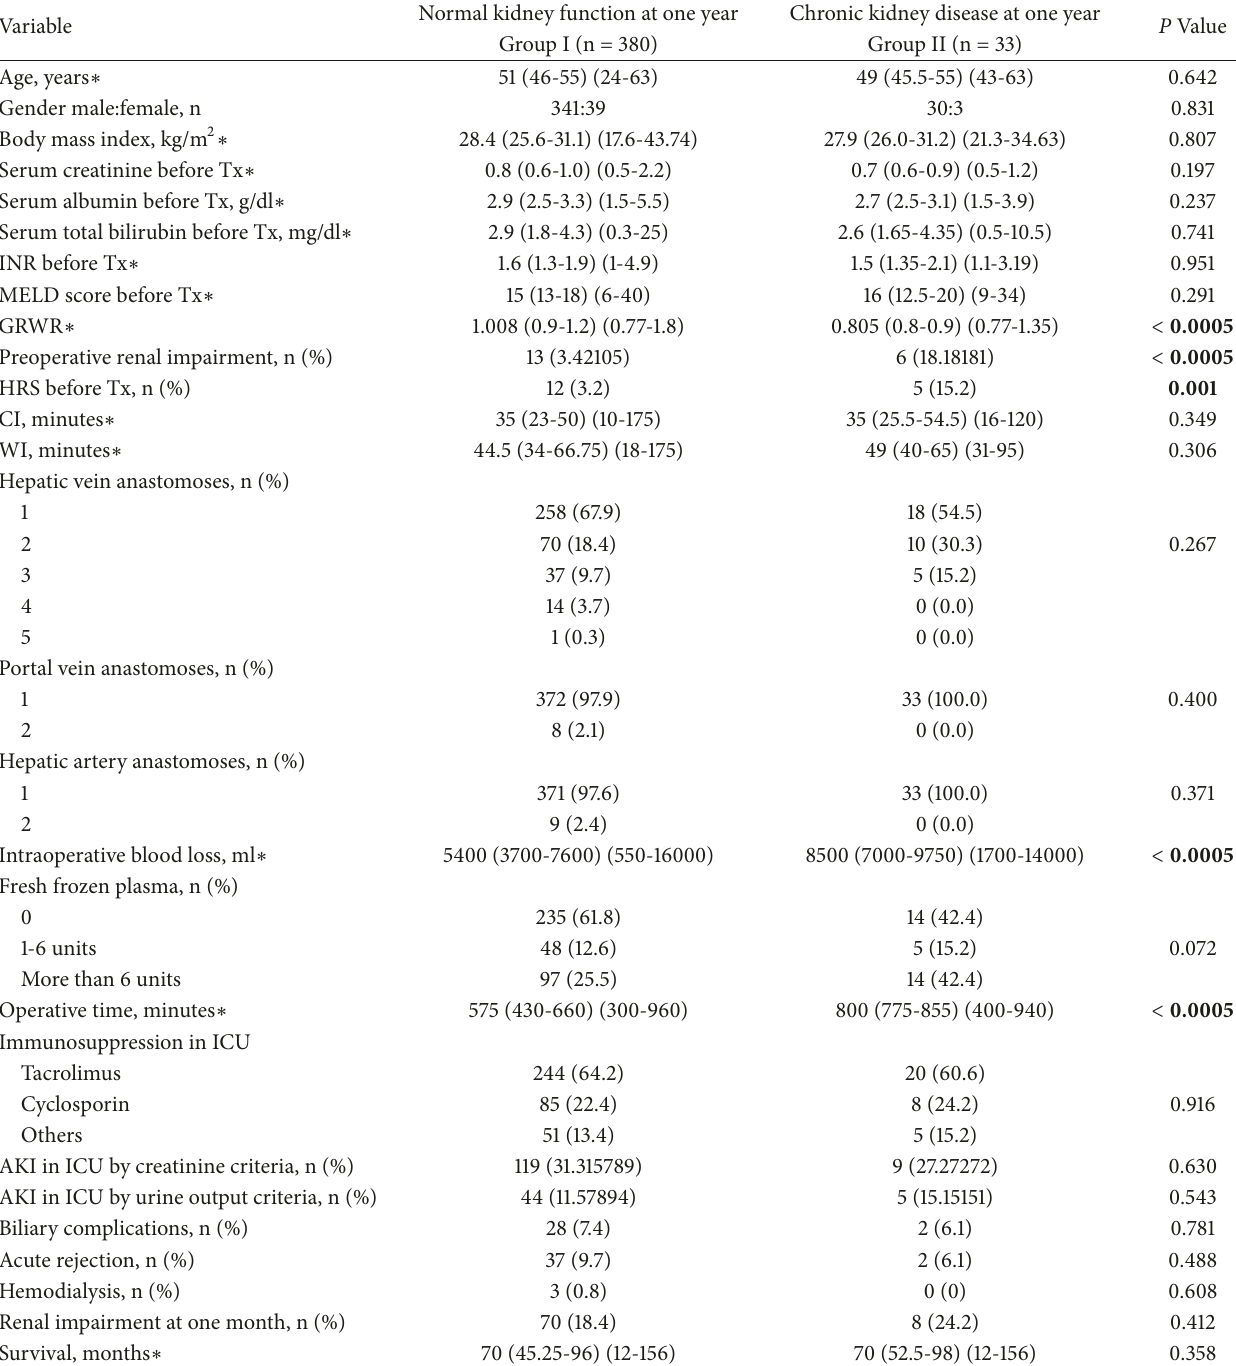
Table 2: Profile of both groups at one year after liver